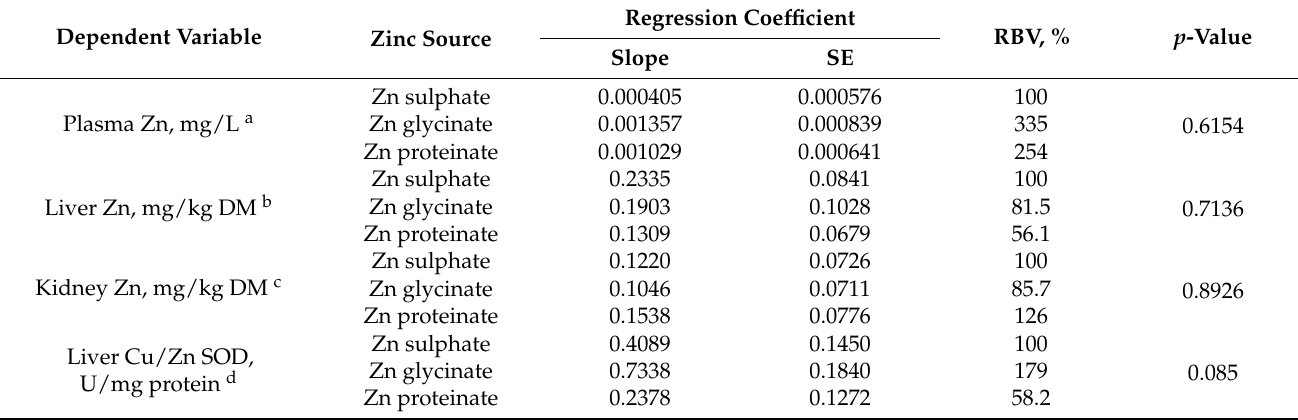
Table 7. Estimated relative bioavailability (RBV) of Zn sources based on linear regression slope ratios of Zn concentrations in tissues and liver activity of Cu/Zn SOD on Zn supplementation level